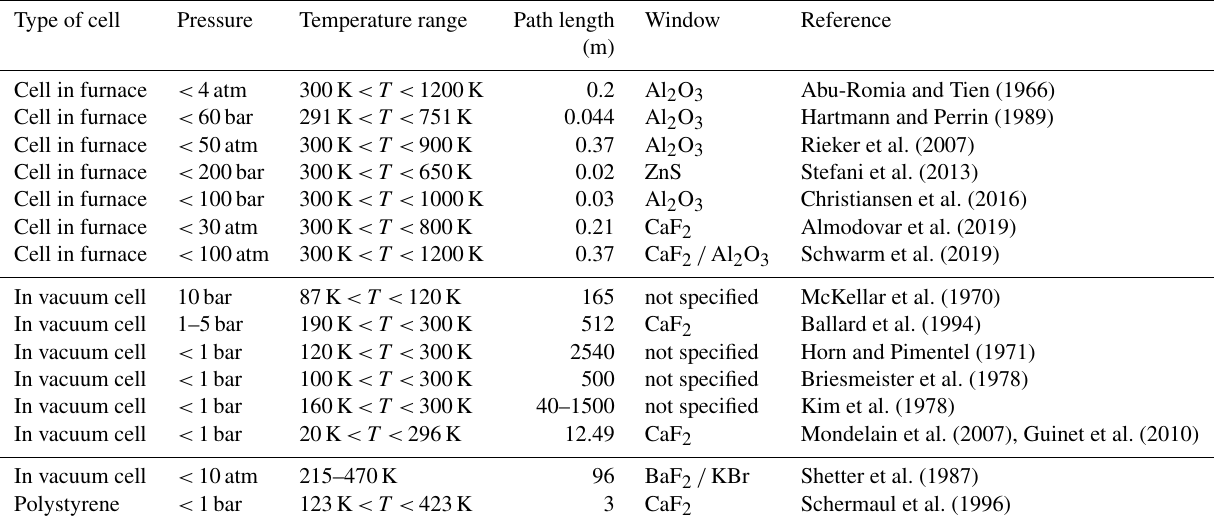
Table 1. The table lists some relevant properties of a number of coolable and heatable absorption cells reported in the literature. The table is not an exhaustive list of such cells but is intended to give an example of what has been achieved in the past. Type of